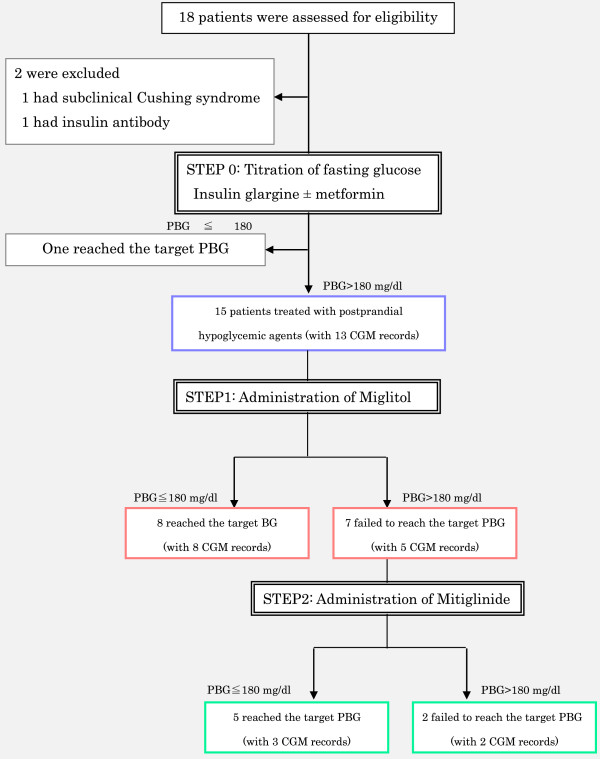
Enrollment and outcomes.